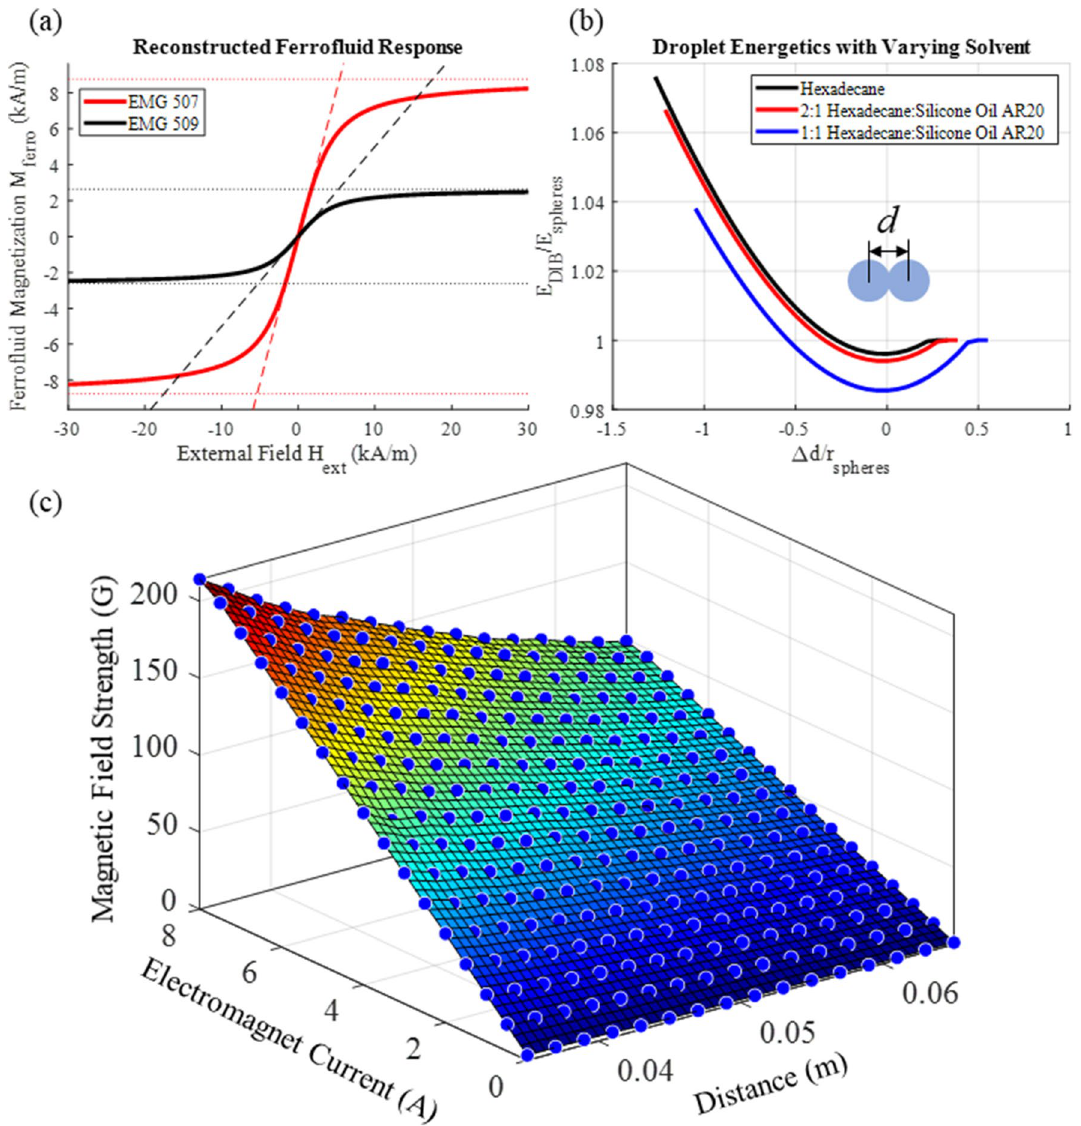
are the linear magnetization response provided by χ ferro , and the dotted lines are the saturation limits. ( b ) Plots of the interfacial energy ( E γ ) for a pair of adhered droplets as a function of the normalized distance between their centers offset by the equilibrium distance. ( c ) Quantified electromagnet response to supplied